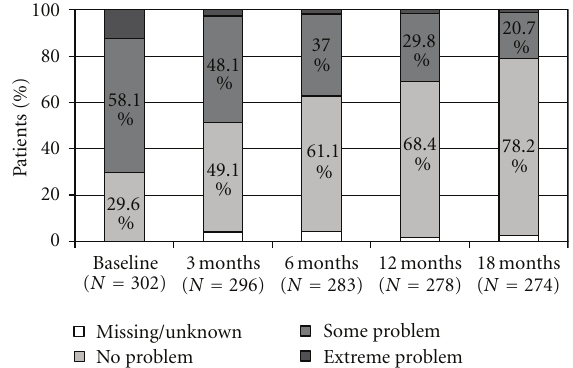
Figure 3: Back pain as defined by patients through the visual anal- ogue scale tool (mm) (mean, SD).